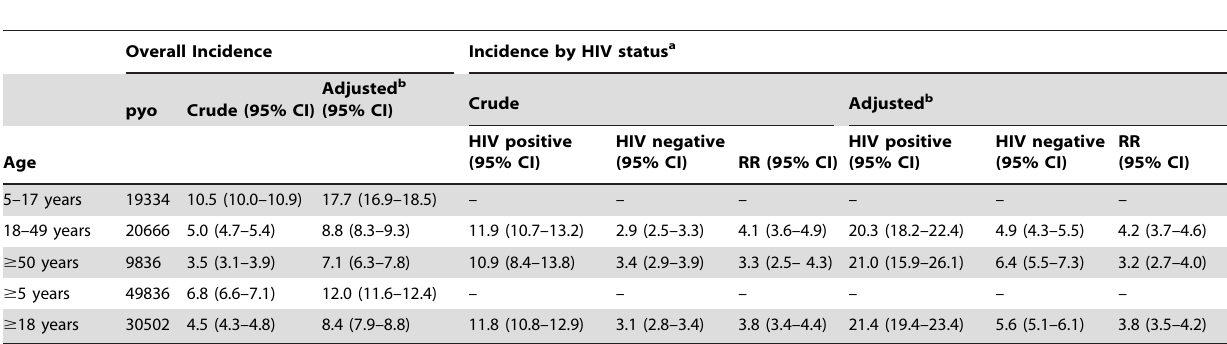
Table 5. Incidence rates of ARI for all persons $ 5 years of age, and among HIV-positive and HIV-negative persons $ 18 years from Lwak Hospital, western Kenya. March 1, 2007,-February 28, 2010.